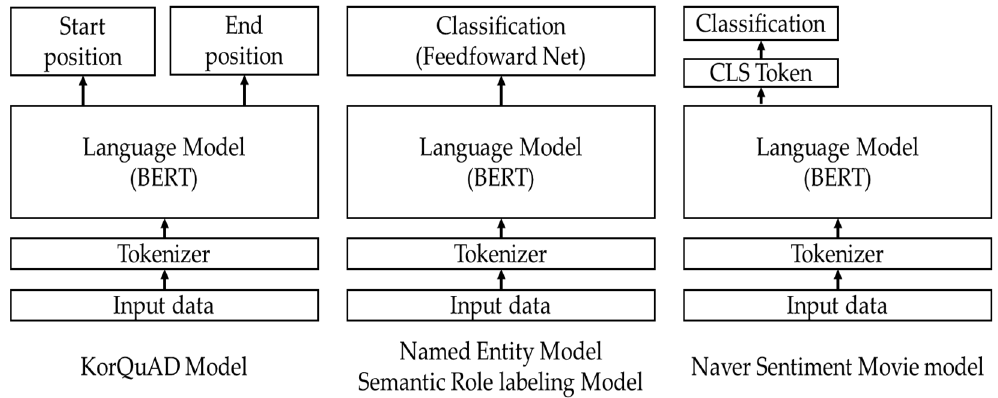
Figure 2. Experimental area (KorQuAD v1.0, NER, SRL, NSMC) usage model.